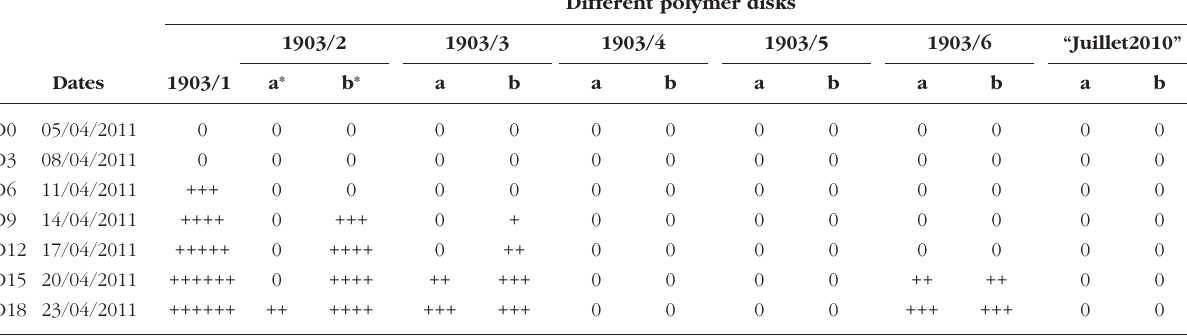
Table IV. – Experiment C: presence and abundance of Ae. albopictus larvae in saucers with different geraniol impregnated polymer disks in an infested area.